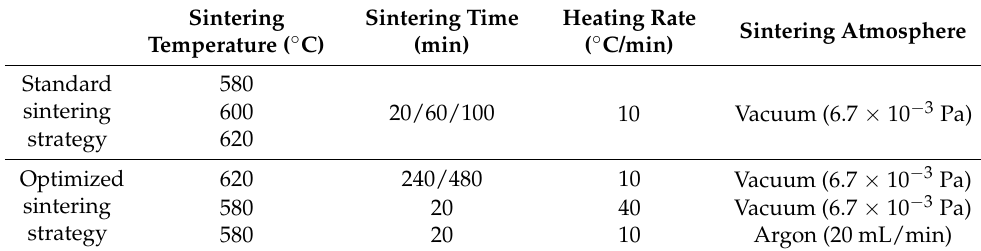
Figure 7. Phase diagram and the amount of liquid phase at different temperatures. Table 3. Different sintering strategies for FDM-like Al7075 alloy